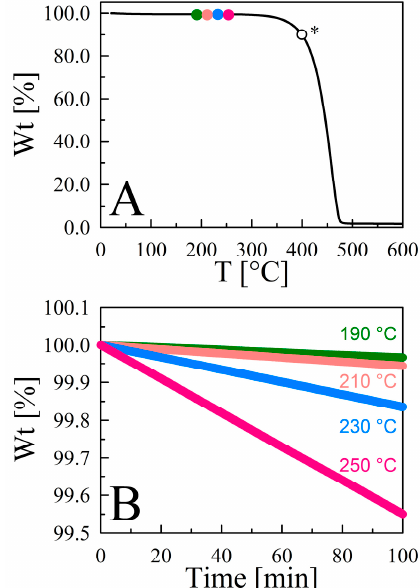
Figure 3. ( A ) Thermal stability of [C 4 mIm][Tf 2 N] under nitrogen purge at a constant flow rate of 60 mL·min − 1 from room temperature to 600 °C (873.15 K) at a heating rate of 10 °C·min − 1 . The color of the symbols on the thermograms in panel A corresponds to the isothermal gravimetric weight loss curves in the lower panel. The open symbol marked * denotes the T dcp (672.65 K) for this sample. ( B ) A normalized magnification showing the rigorously linear ( r 2 ≥ 0.9999) evaporation curves of [C 4 mIm][Tf 2 N] at different temperatures.